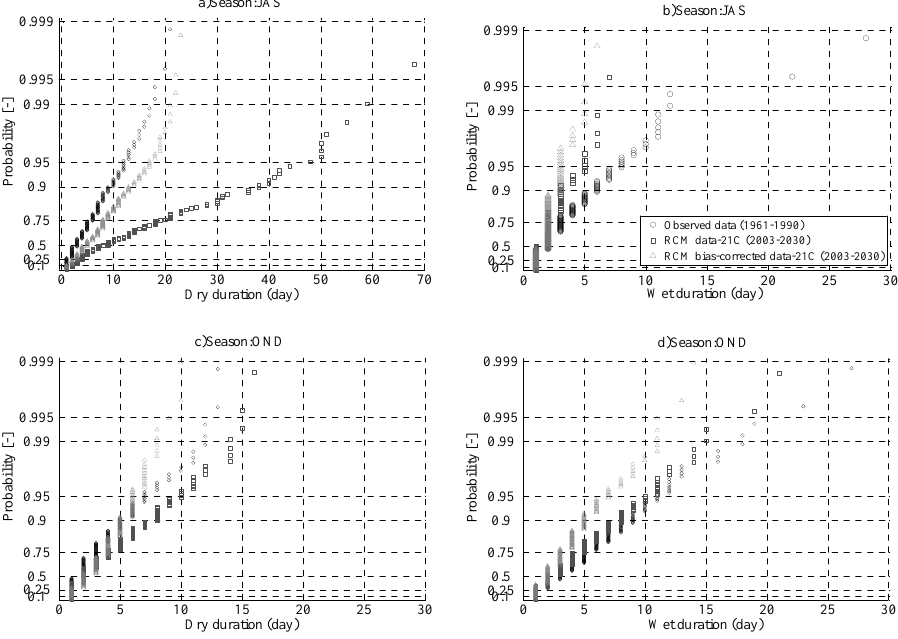
Fig. 11. Comparison for one RCM grid-cell (cell #4) between the probability plots of dry and wet periods obtained from the reference observations (circles), the RCM output for the 21st century (squares) and the bias-corrected rainfall (triangles). The two seasons, with the larger alteration in the 21st century, are reported for the summer dry periods (a) , the summer wet durations (b) , the autumn dry periods (c) , the autumn wet durations (d) .